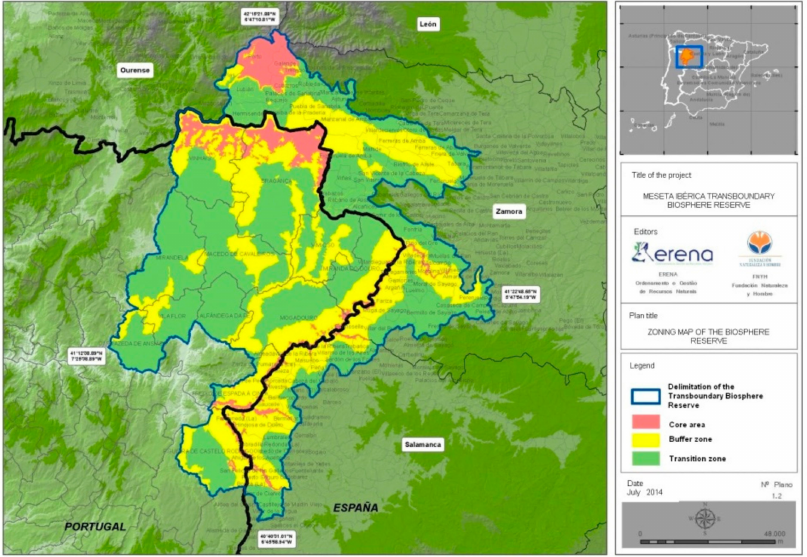
Figure 1. Meseta Ib é rica Transboundary Biosphere Reserve